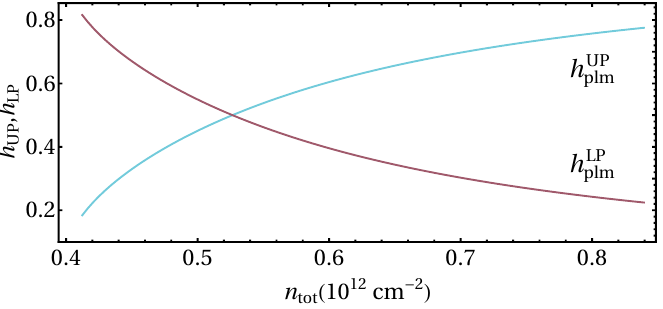
Figure 4. (Color online) Hopfield coefficients Equations (32) as a function of the total doping density n tot in the quantum